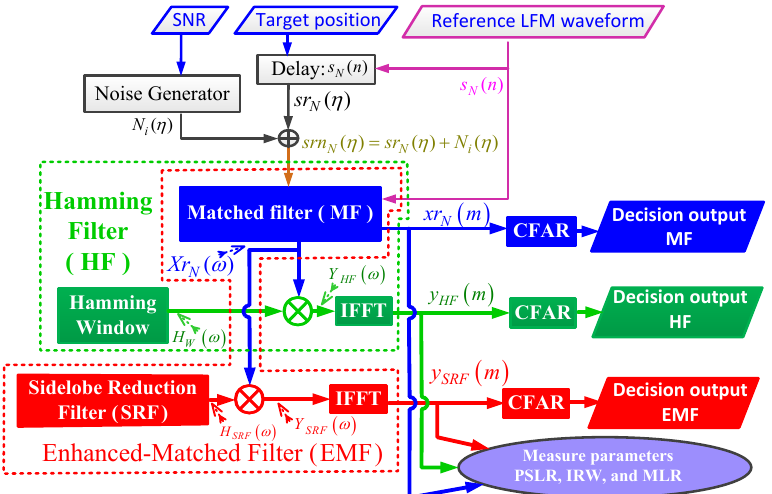
Figure 11. Flowchart of the performance analysis of MF, HF, and the proposed EMF for a single target. The performance analysis was carried out through the following